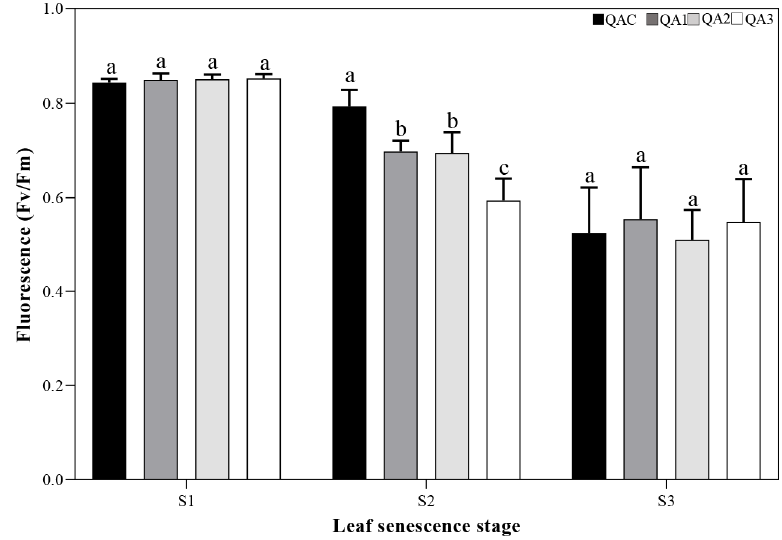
Figure 2. Changes in potential maximum maximal quantum yield of PS II (Fv/Fm) during leaf senescence. Bars represent the standard deviation (SD, n = 3), and lowercase letters represent significant differences at p < 0.05.